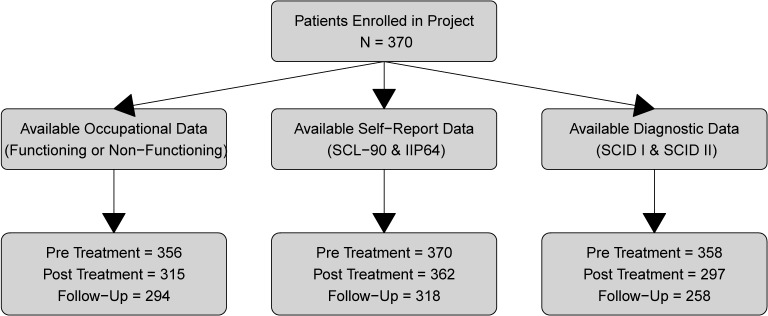
Patient attrition.